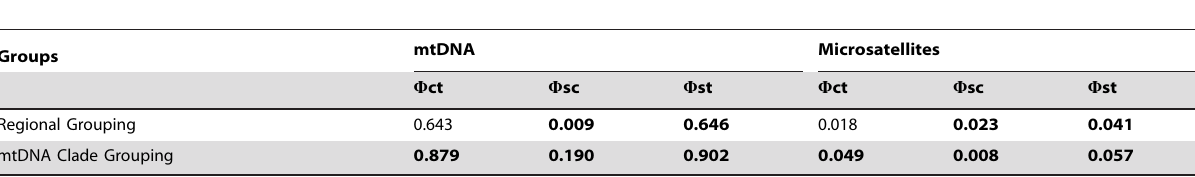
Table 9. AMOVA results for both mtDNA and microsatellite data for alternative grouping of